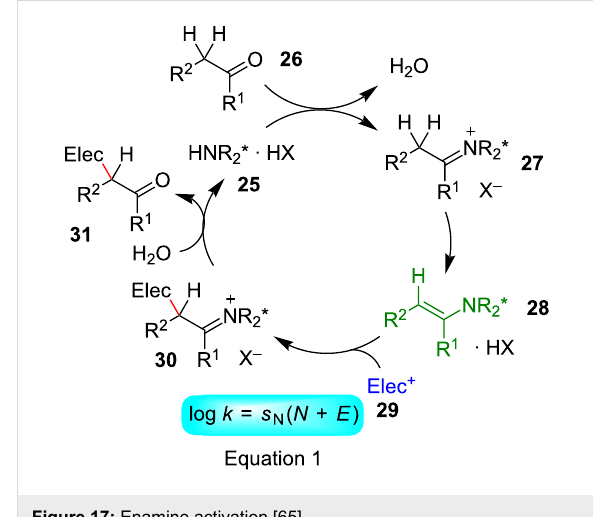
Figure 17: Enamine activation